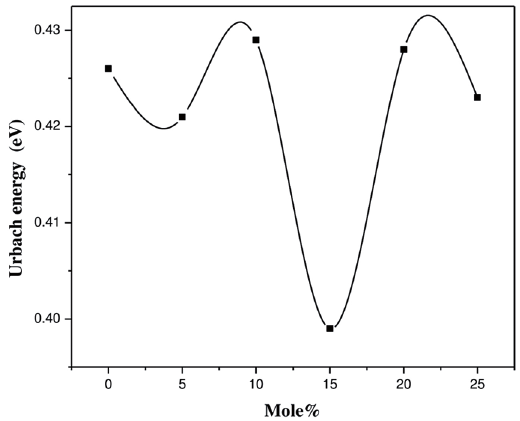
Figure 6: Compositional dependence of Urbach energy (ΔE) in the present glasses.